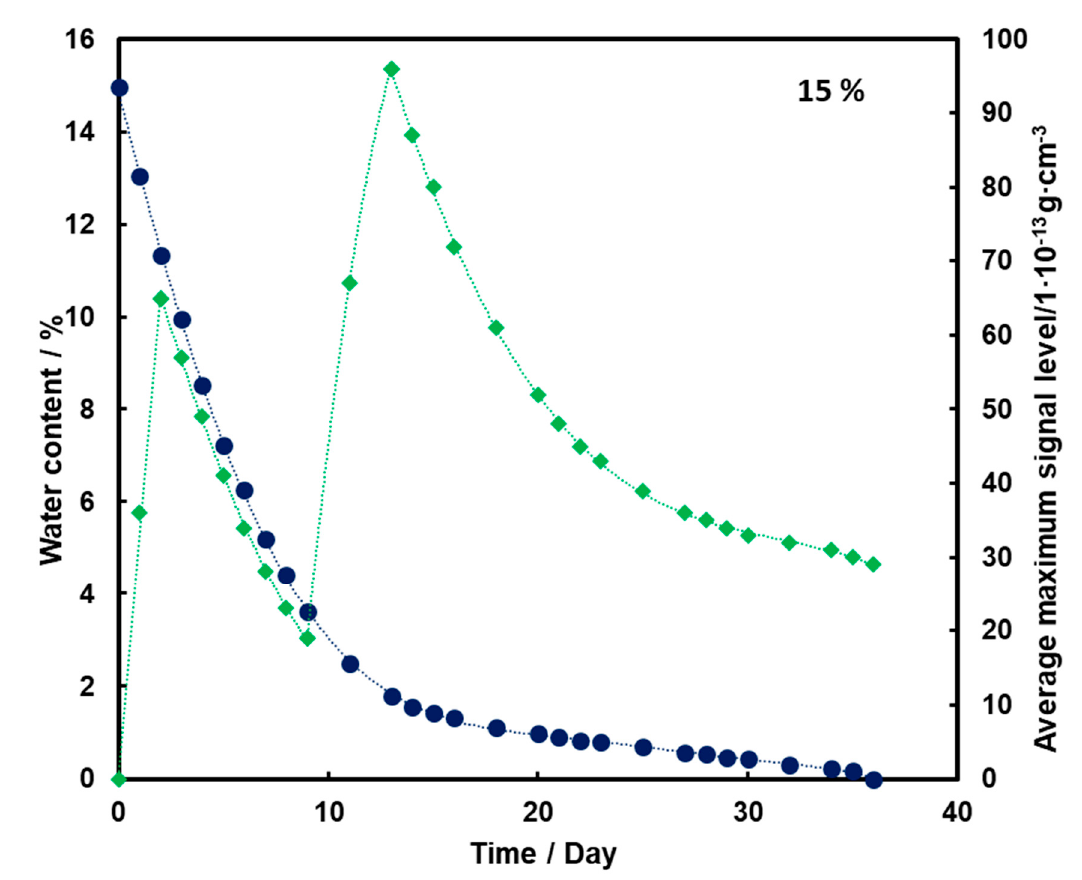
Figure 5. Dependence of the mean maximum TNT signal ( ♦ ) on the amount of water ( ● ) in time for a substrate with a moisture content of 15%.